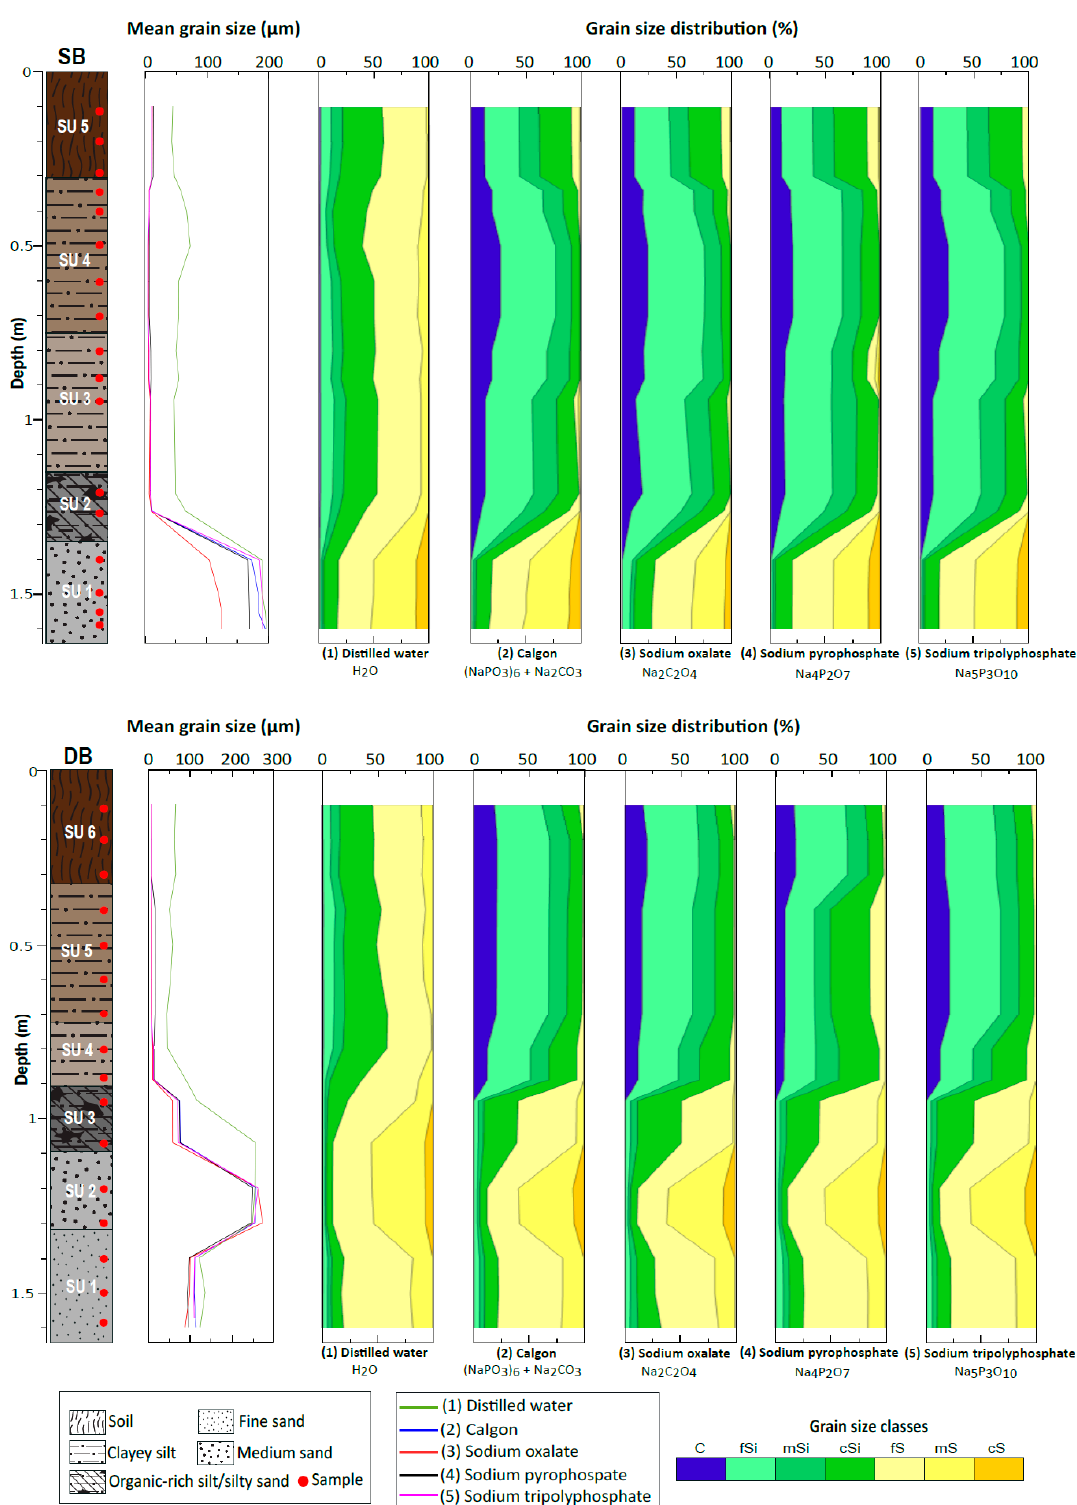
Figure 2. Lithologic profiles, mean grain size, and granulometric fractions of Spitzbrunnen (SB) and Daschsbrunnen (DB) sediment cores. The grain size data represent the results of measurements using five different dispersants. Grain size classes are based on the modified Udden–Wentworth scale. (C: clay; fSi: fine silt; mSi: medium silt; cSi: coarse silt; fS: fine sand; mS: medium sand; cS: coarse sand.).